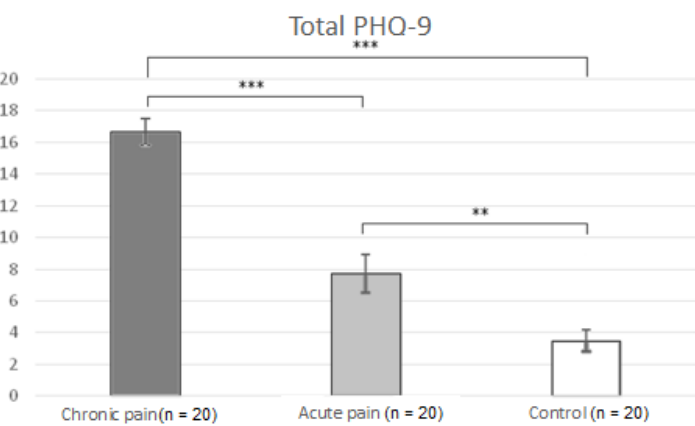
Figure 3. Means and typical errors of depression scores in the three groups (chronic pain vs. acute pain vs. control). ** p < 0.01, *** p <